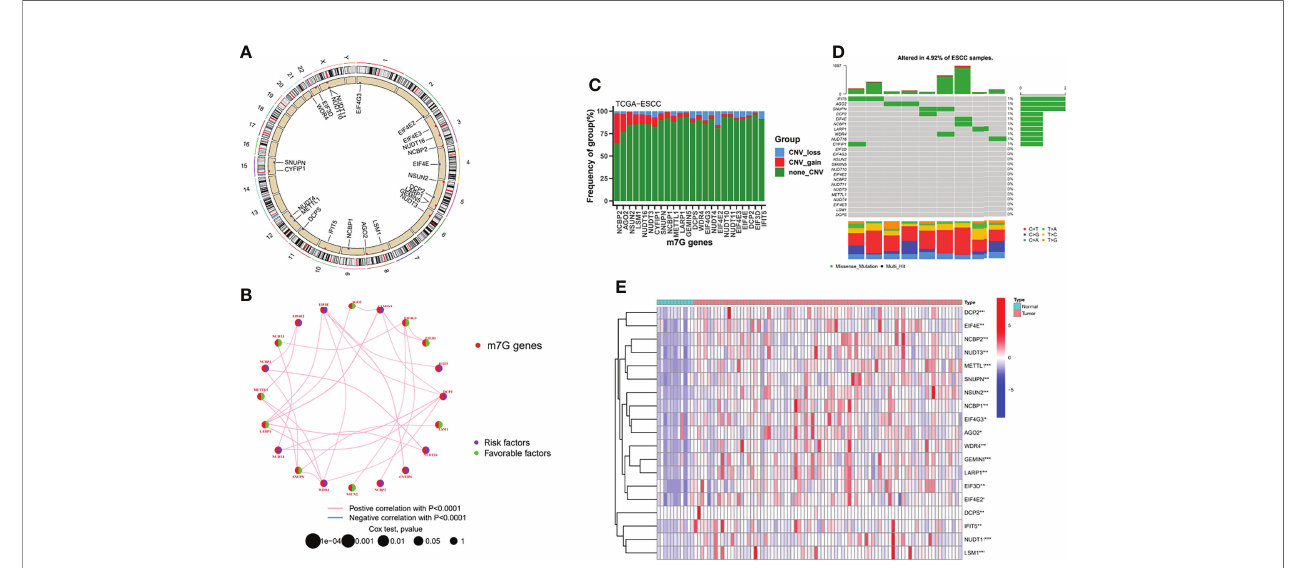
FIGURE 1 | Landscape of m7G regulators in ESCC. (A) Location of the 21 m7G regulators in the chromosome. (B) Interactions among m7G regulators in ESCC. (C) The CNV variation frequency of m7G regulators in the TCGA-ESCC cohort. (D) The mutation frequency and classi fi cation of m7G regulators. (E) Heatmap indicated the differences in the expression of m7G regulators in normal and tumor tissues. * P <0.05; ** P <0.01; *** P <0.001.